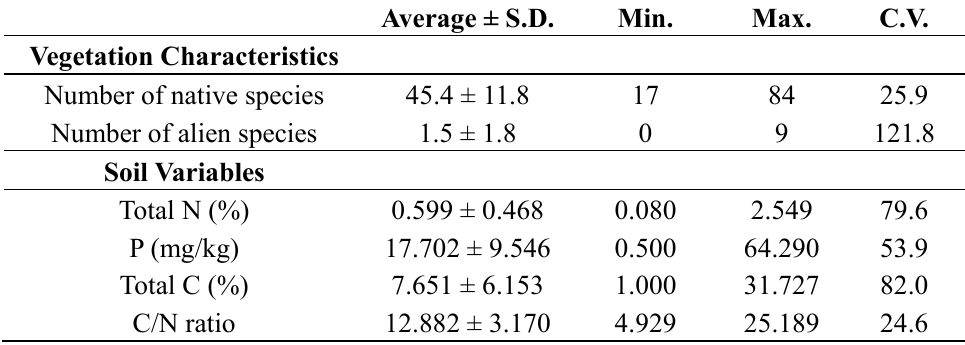
Table 1. Descriptive statistics of species richness characteristics and ecological variables ( n = 240).